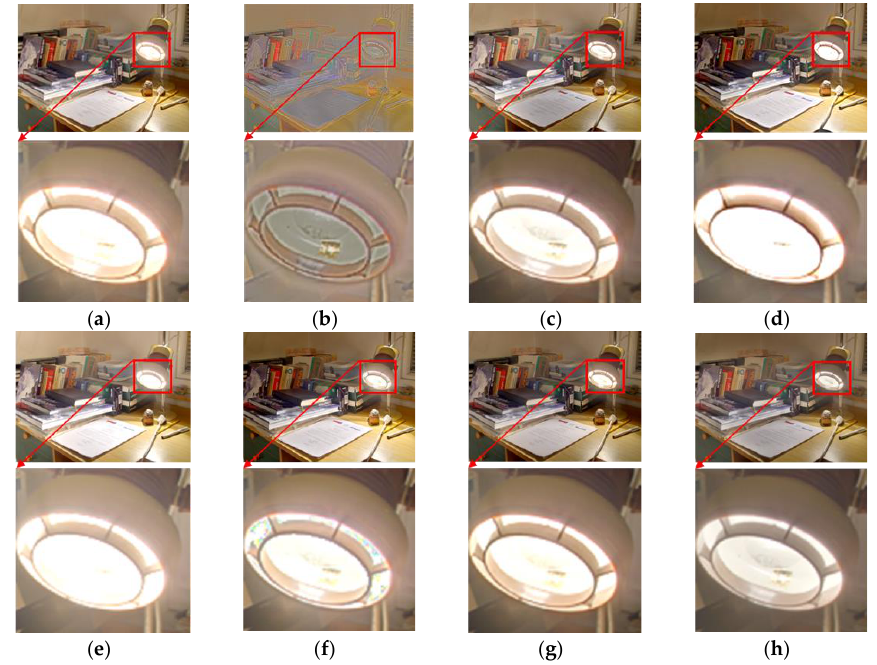
Figure 6. Fusion results for Figure 4b. ( a ) Mertens et al.’s method [ 16 ] . ( b ) Shen et al.’s method [ 21 ] . ( c ) Li et al.’s method [ 22 ] . ( d ) Ma et al.’s method [ 24 ] . ( e ) Hayat et al.’s method [ 25 ] . ( f ) Qi et al.’s method [ 27 ] . ( g ) Huang et al.’s method [ 28 ] . ( h ) The proposed method.